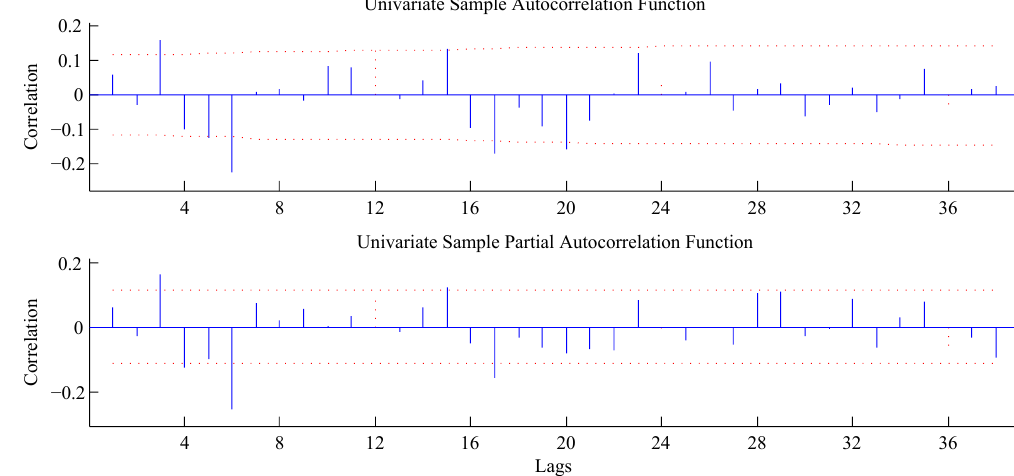
Figure 4. Autocorrelation function (ACF) and partial ACF (PACF) of the residual component for the ARIMA 2 model of 5 June 2016.